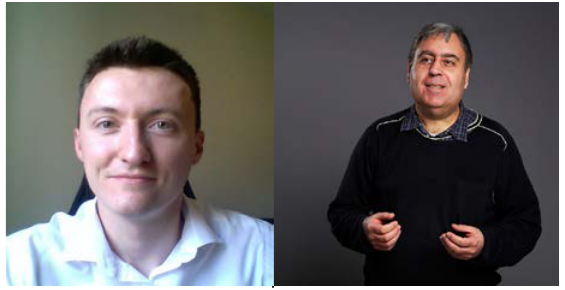
Figure 3. Dr. Dakka’s research group.